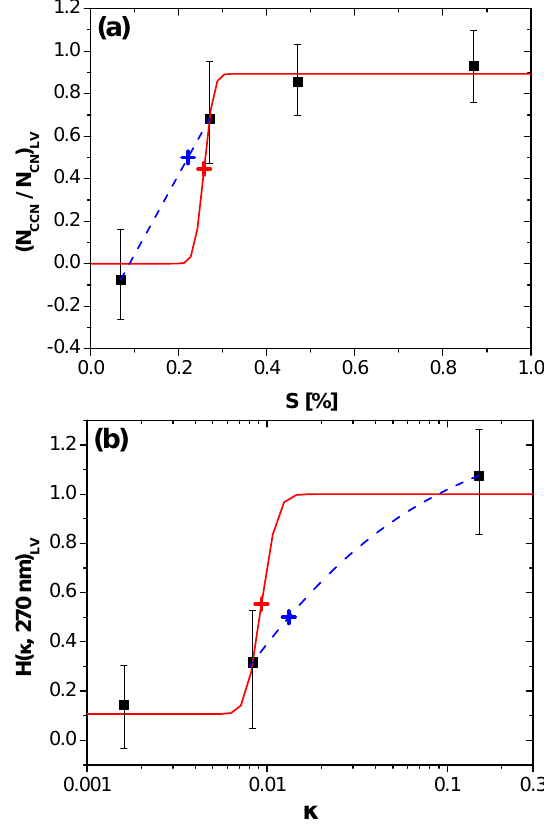
Fig. 8. (a) CCN efficiencies plotted against supersaturation and (b) cumulative hygroscopicity distribution for LV-particles of 270nm plotted against the hygroscopicity parameter, κ . Black data points are campaign median values of the data points calculated by Eq. (2), error bars extend to their lower and upper quartiles. The red line is a 3-parameter CDF fit to the black data points and the red cross is the point of (a) the midpoint supersaturation and (b) the median value of κ obtained from the fit. The dashed blue line represents an alter- native approach (linear interpolation) for calculating approximate midpoint values (blue